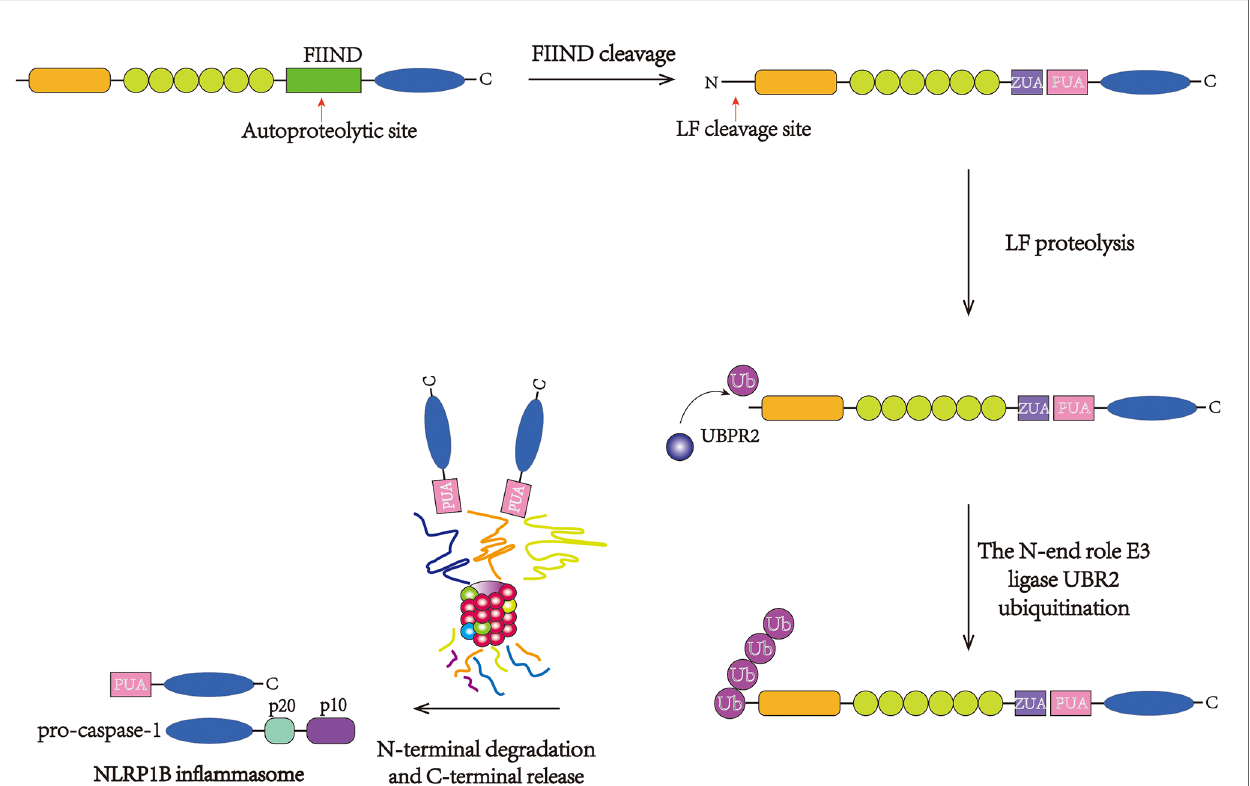
FIGURE 3 | Direct activation of the NLRP1B in fl ammasome. NLRP1B undergoes autoproteolysis at the FIIND and generates the ZU5 and UPA subdomains. Then, LF cleavage between the K44 and L45 residues in the N-terminus produces an unstable N-terminal residue. The neo-N-terminus is subsequently recognized and ubiquitinated by the N-end rule E3 ligase UBR2, initiating proteasome-mediated degradation. The C-terminal fragment is free to recruit and stimulate